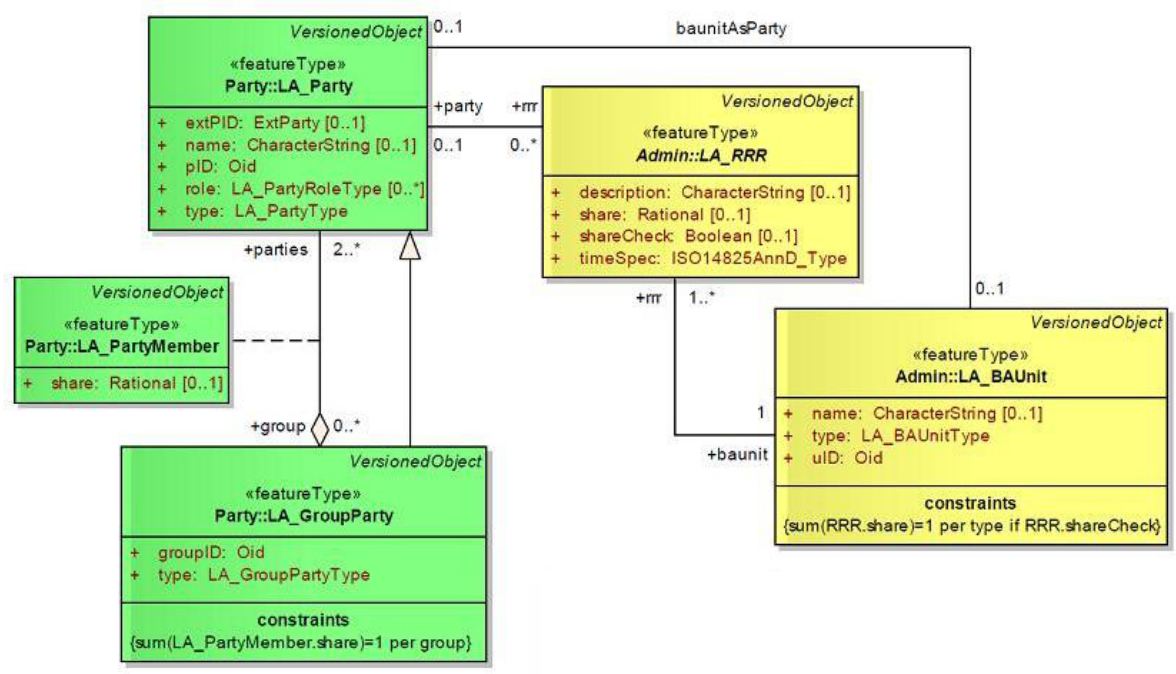
Figure 1, LADM Party package classes, Lemmen et al